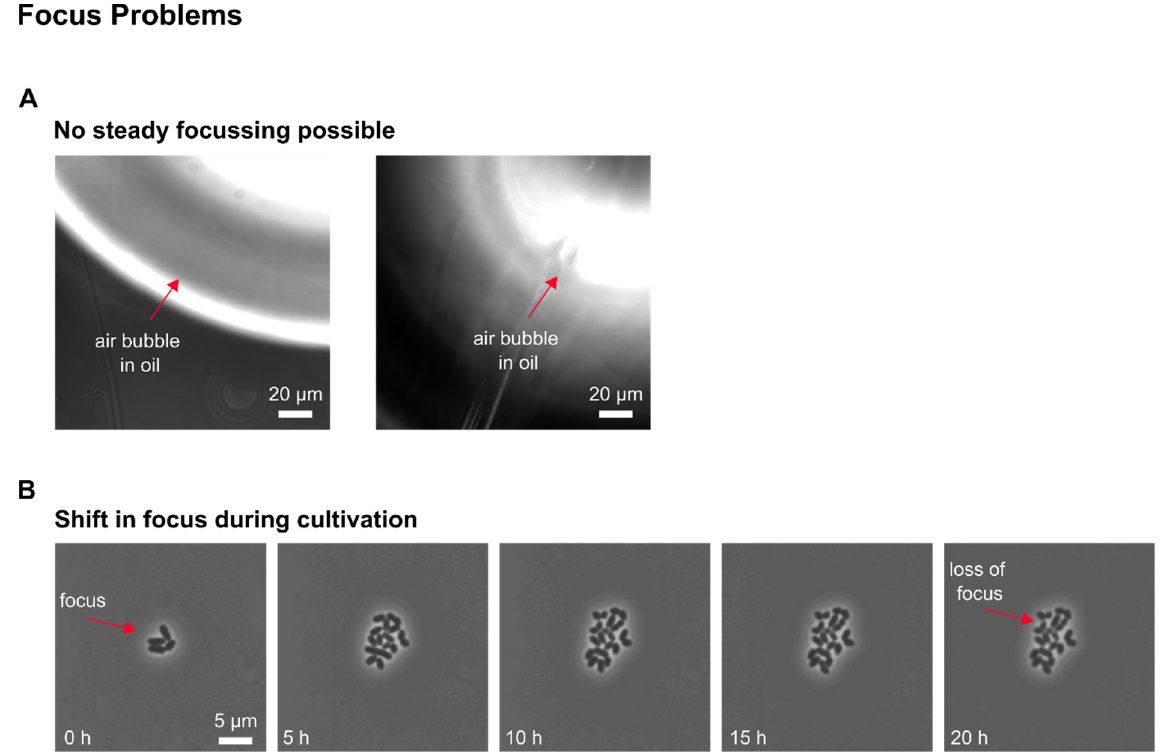
Figure A7. Example images of blurry images (see Table 10). Microscope image of gradients inside the image.